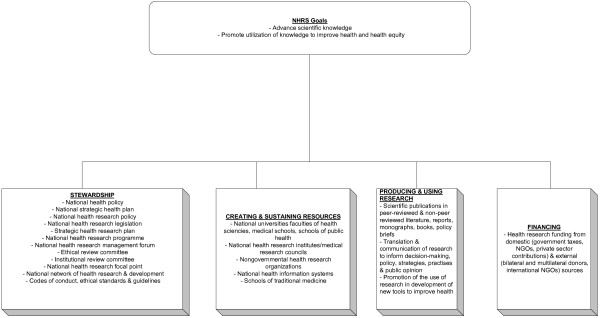
National health research systems conceptual framework. Source: Adapted from Pang et al [12].